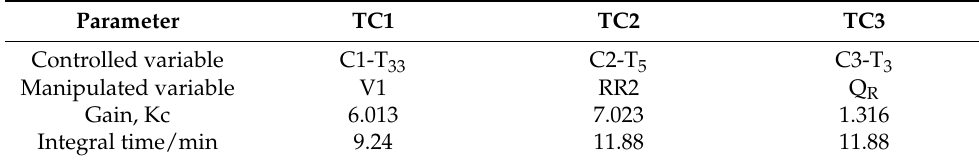
Table 3. Tuning parameters of temperature controllers in CS2.